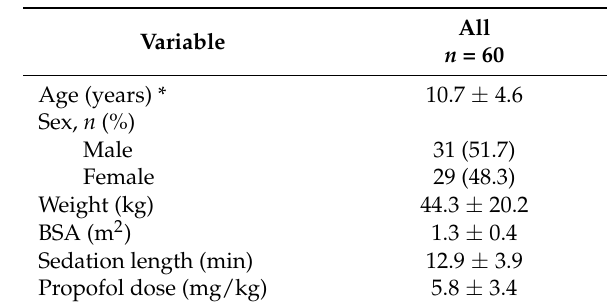
Table 1. Demographics of the subject